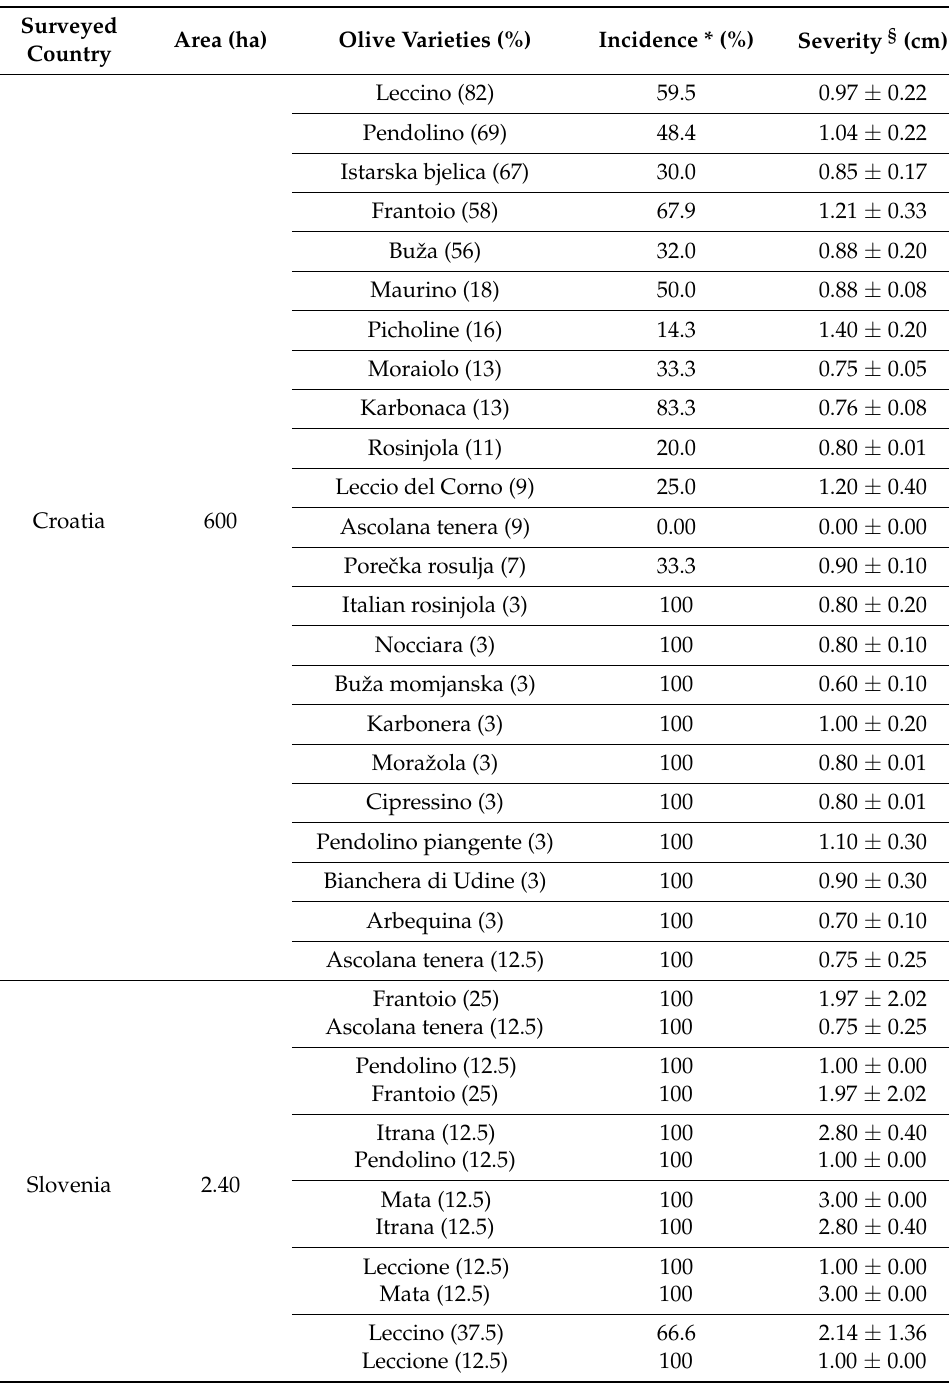
Table 1. Incidence of olive knot disease on different olive varieties in surveyed Croatian, Slovenian and Portuguese olive orchards. Surveyed Area (ha) Olive Varieties Country